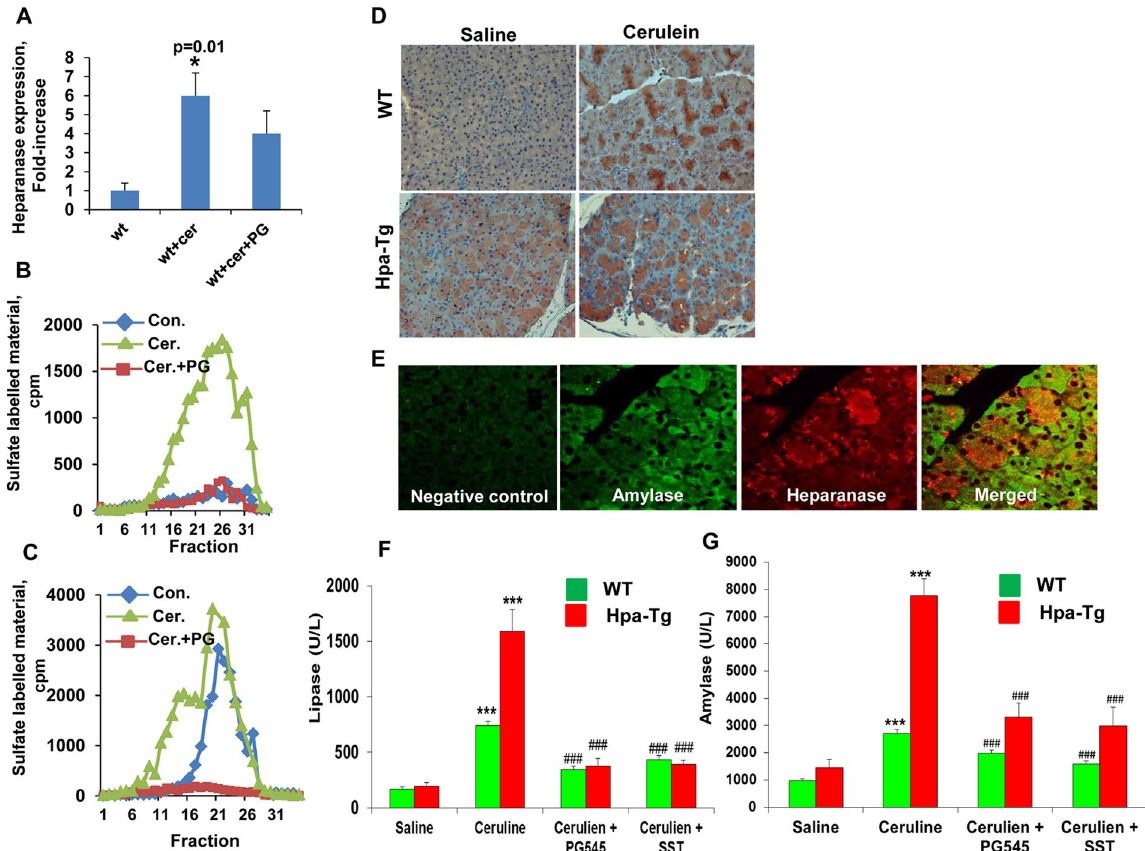
Figure 1. ( A ) Cerulein treatment induces heparanase expression. Pancreas tissue was harvested from control mice (WT) or mice treated with cerulein in the absence (wt + cer) or presence of PG545 (wt + cer + PG). Total RNA was extracted and subjected to quantitative real-time PCR applying heparanase primers. Relative heparanase gene expression (fold-increase) is shown graphically in relation to heparanase levels in control pancreas set arbitrarily to a value of 1. Heparanase mRNA levels were normalized to actin mRNA (number of mice in each group = 5); * p < 0.01 for control vs. cerulein. Heparanase enzymatic activity was evaluated in corresponding control (blue), cerulein (green) and cerulean + PG545 (red) pancreatic tissue extracts ( B ). Note most noticeable increase in heparanase activity following cerulein treatment, which is almost completely inhibited by PG545. ( C ) Heparanase activity was similarly evaluated in pancreatic tissues harvested from Hpa-Tg (blue), Hpa-Tg + cerulein (green) and Hap-Tg + cerulean + PG545 (red). ( D,E ) Immunostaining. Control untreated (Saline) and cerulein-treated pancreas tissues were harvested from WT (upper panels) and Hpa-Tg (lower panels) mice, fixed with formalin and embedded in paraffin. 5-micron sections were subjected to immunostaining applying anti-heparanase antibody ( D ). ( E ) Corresponding sections of cerulein-treated WT mice were subjected to immunofluorescence staining applying anti-amylase (green, second left panel) and anti-heparanase (red, second right panel) antibodies. Merged image is shown in the right panel. Background staining, omitting the primary antibody, is shown in the left panel (Negative control). Note co-localization (orange-yellow) of amylase and heparanase in acinar cells. Shown are representative images at x20 original magnification. ( F,G ) Induction of lipase and amylase by cerulein is restored by heparanase inhibitors. Blood samples were collected from control untreated WT (n = 13) or Hpa-Tg (n = 11) mice (saline) or mice treated with cerulein in the absence (cerulein; n = 24) or presence of PG545 (cerulean + PG545; n = 20) or SST0001 (cerulean + SST; n = 6) and evaluated biochemically for lipase ( F ) and amylase ( G ) levels. *** P < 001 for saline vs. cerulein; ### P < 001 for cerulein vs. cerulean + PG545/SST. Note, reduced levels of lipase and amylase in mice treated with the heparanase